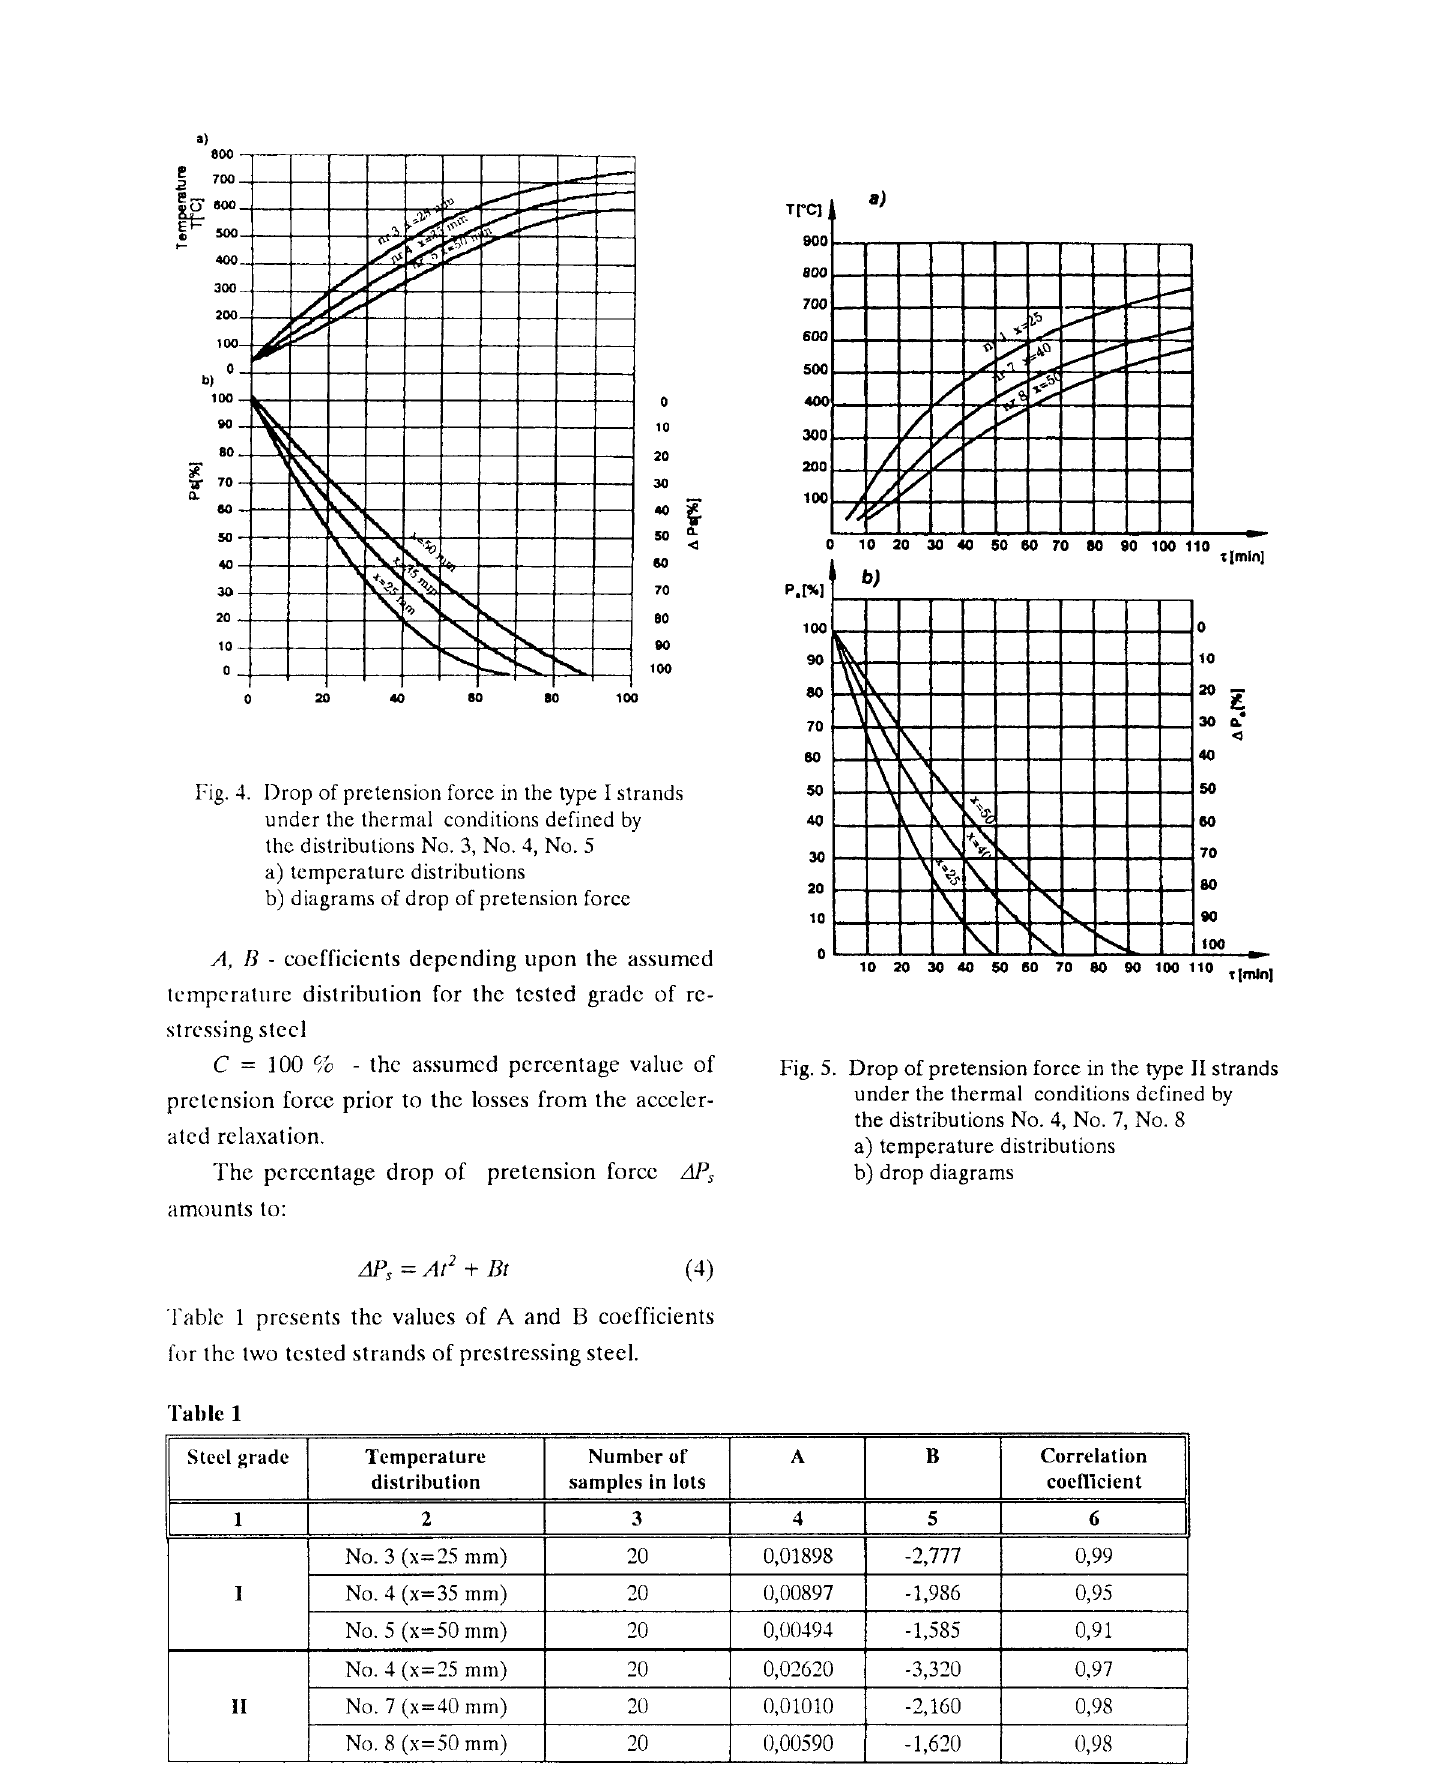
Fig. 5. Drop of pretension force in the type II strands under the thermal conditions defined by the distributions No. 4, No. 7, No. 8 a) temperature distributions b) drop